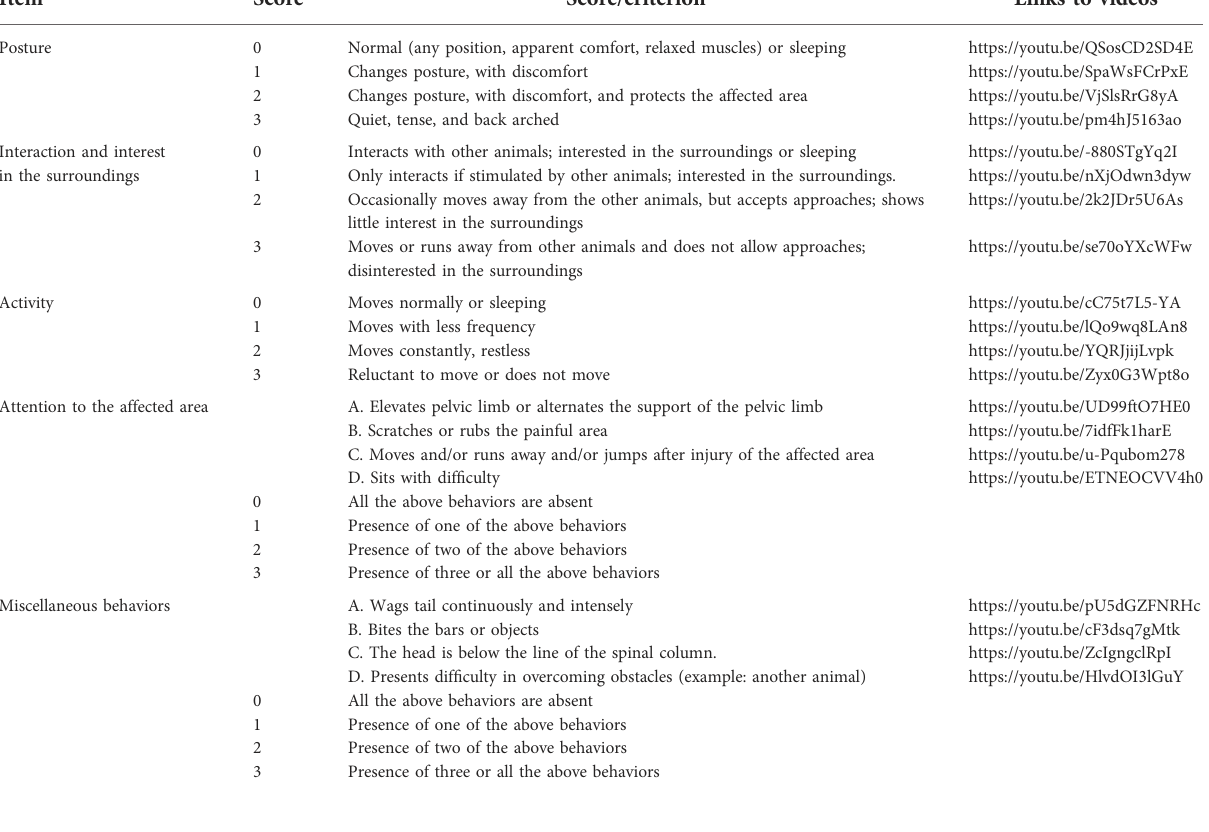
TABLE 2 The UNESP-Botucatu composite pain scale (UPAPS) for scoring pain in piglets.